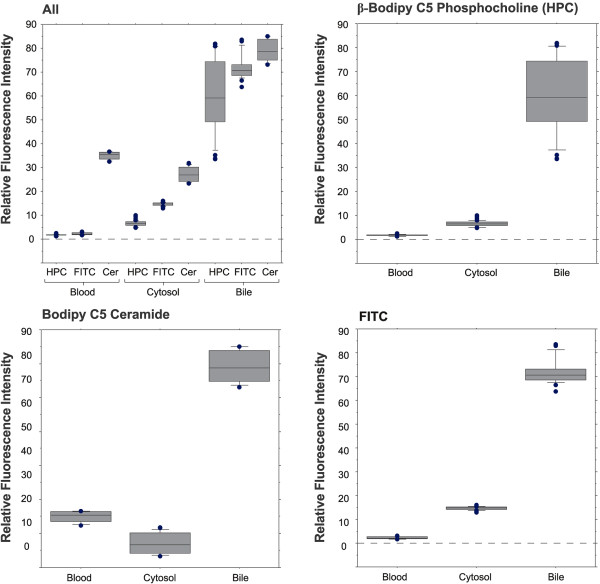
Quantitative analysis of blood to bile transport in vivo (STII medaka, 12 dpf): β-Bodipy C5 Phosphocholine (HPC), Fluorescein Isothiocyanate (FTIC) and Bodipy C5 ceramide. Box plots (area averages) and statistical indices: Quantitative analysis of differential blood to bile transport between β-Bodipy C5 phosphocholine (HPC), fluorescein isothiocyanate (FTIC) and Bodipy C5 ceramide. Fluorophores were imaged in vivo at peak uptake times (60 minutes for C5 ceramide, 45 minutes for both FITC and HPC). Differences in blood to bile transport between all three fluorophores were suggested when measured values (means) of fluorescence intensity across sinusoid, cytosol and canalicular spaces were evaluated. The most marked differences were between β-Bodipy C5 phosphocholine and fluorescein isothiocyanate, and Bodipy C5 ceramide. For instance: Where ceramide and FITC showed no statistical difference in concentration in the canaliculus, there were marked differences in concentration, and temporal variation, in cytosol and sinusoid, suggesting differences in transport kinetics.